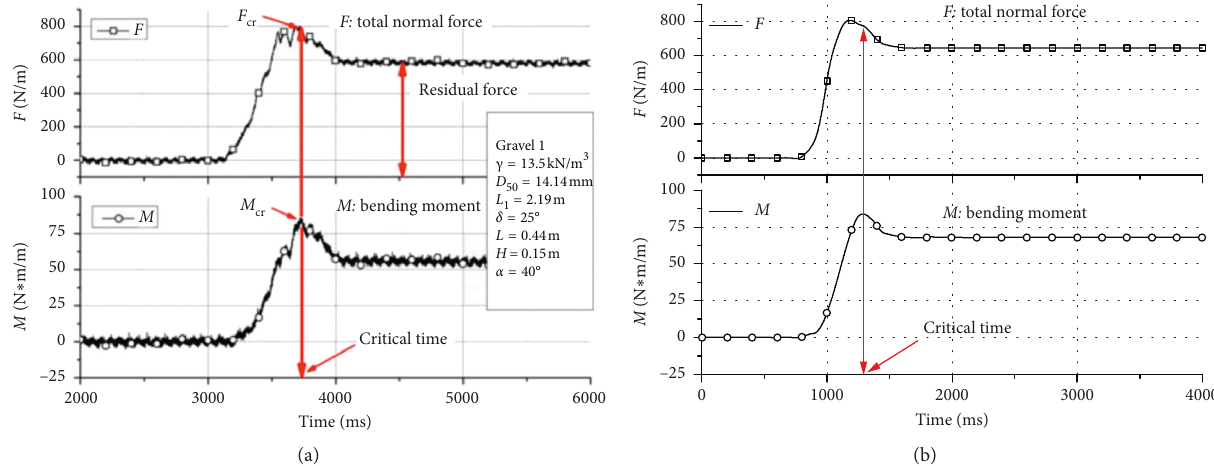
Figure 6: Time history of the total unit-width normal force and moment ( L 44- H 15- α 40 ° ): (a) the experimental data [45]; (b) the numerical results [30].